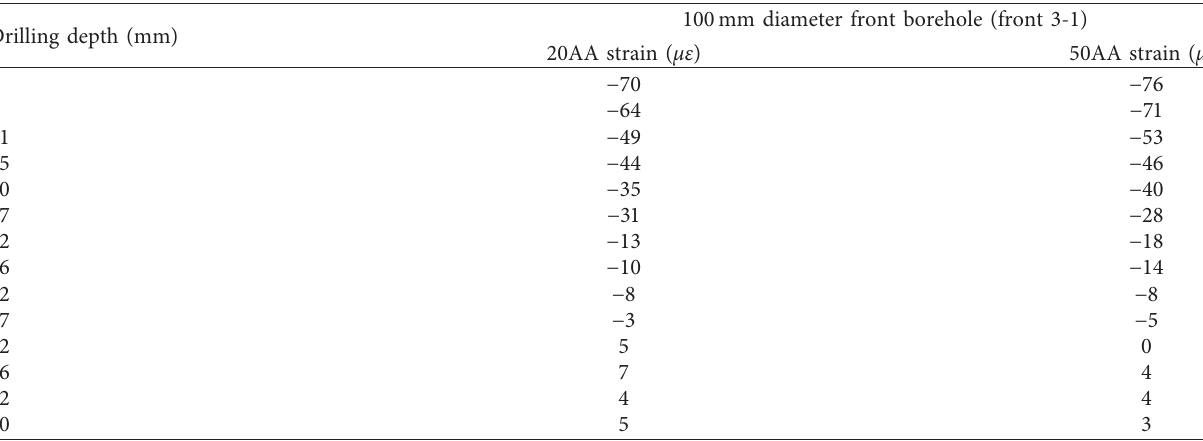
Table 5: Experimental measurements collected from the third beam.